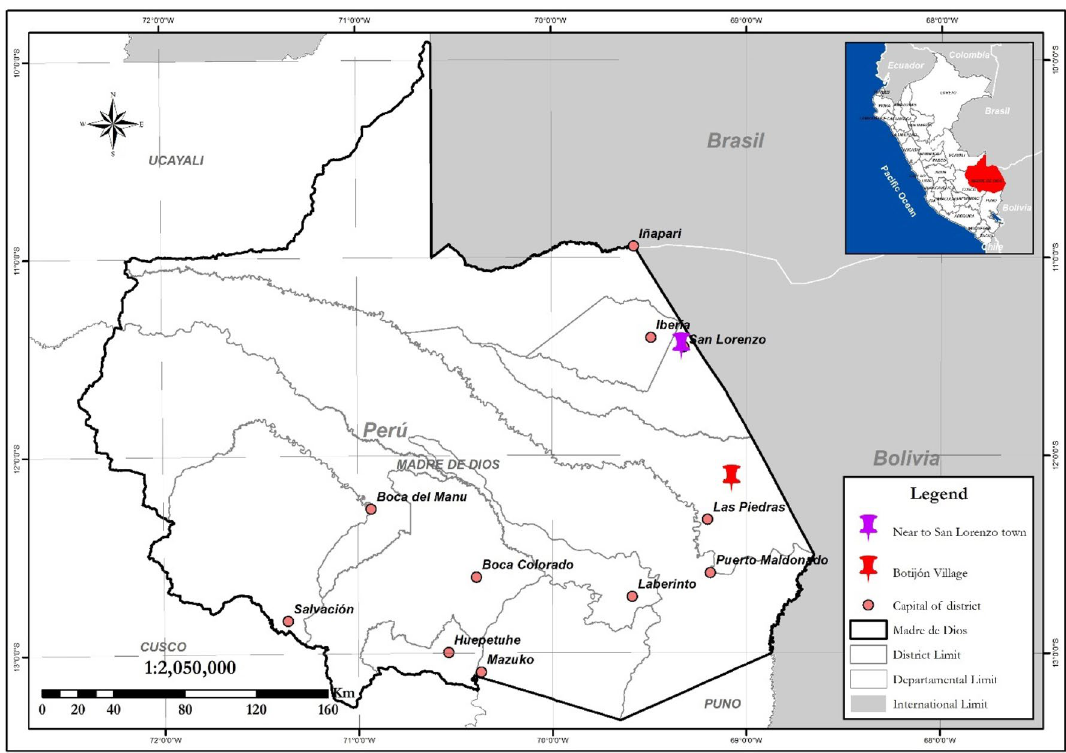
Figure 1. Botijón Village where samples were collected, and San Lorenzo town where cattle farming is practiced. This map was created with the Geoservidor https:// geose rvidor. minam. gob. pe/ edited with